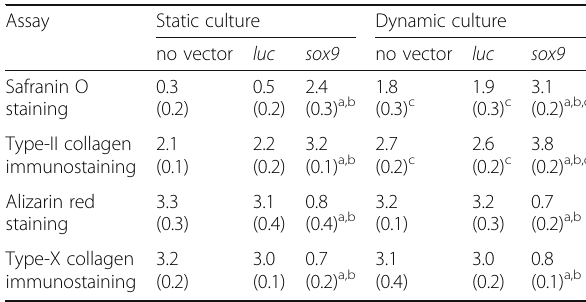
Table 3 Histomorphometric analyses in the rAAV-transduced human bone marrow aspirates (day 21)